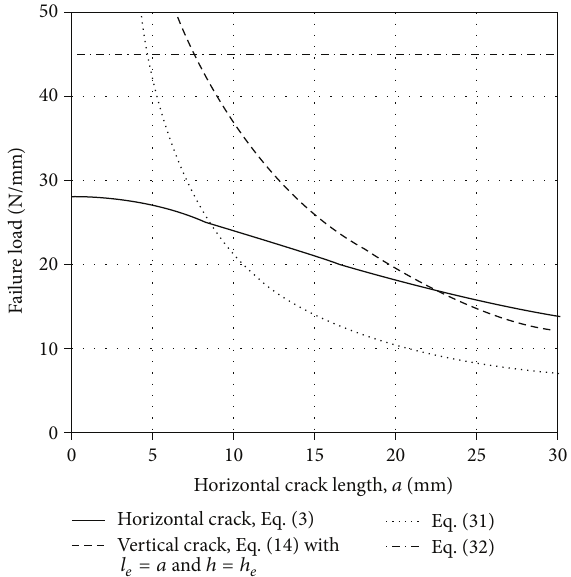
Figure 10: Example of propagation of horizontal crack including possible bending and shear failure modes and change of crack propagation